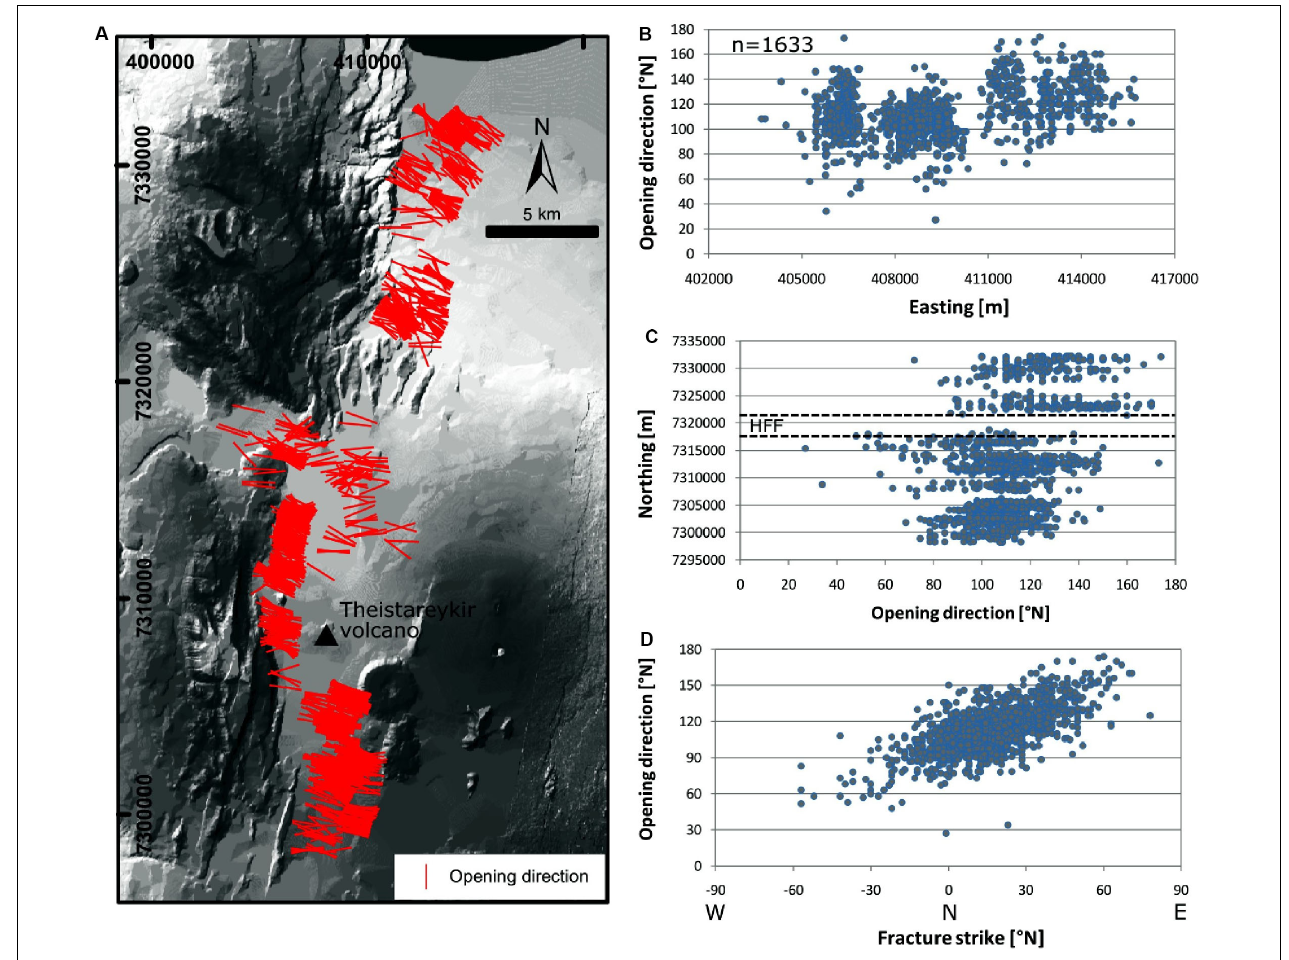
FIGURE 6 | (A) Map of opening directions (lines) obtained along extension fractures, (B) graph of opening directions ( Y axis) vs. Easting ( X axis), (C) graph of opening directions ( X axis) vs. Northing ( Y axis), the intersection with the HFF is shown, (D) graph of opening directions ( Y axis) vs. extension fracture strikes ( X axis). Spatial reference: WGS 84/UTM zone